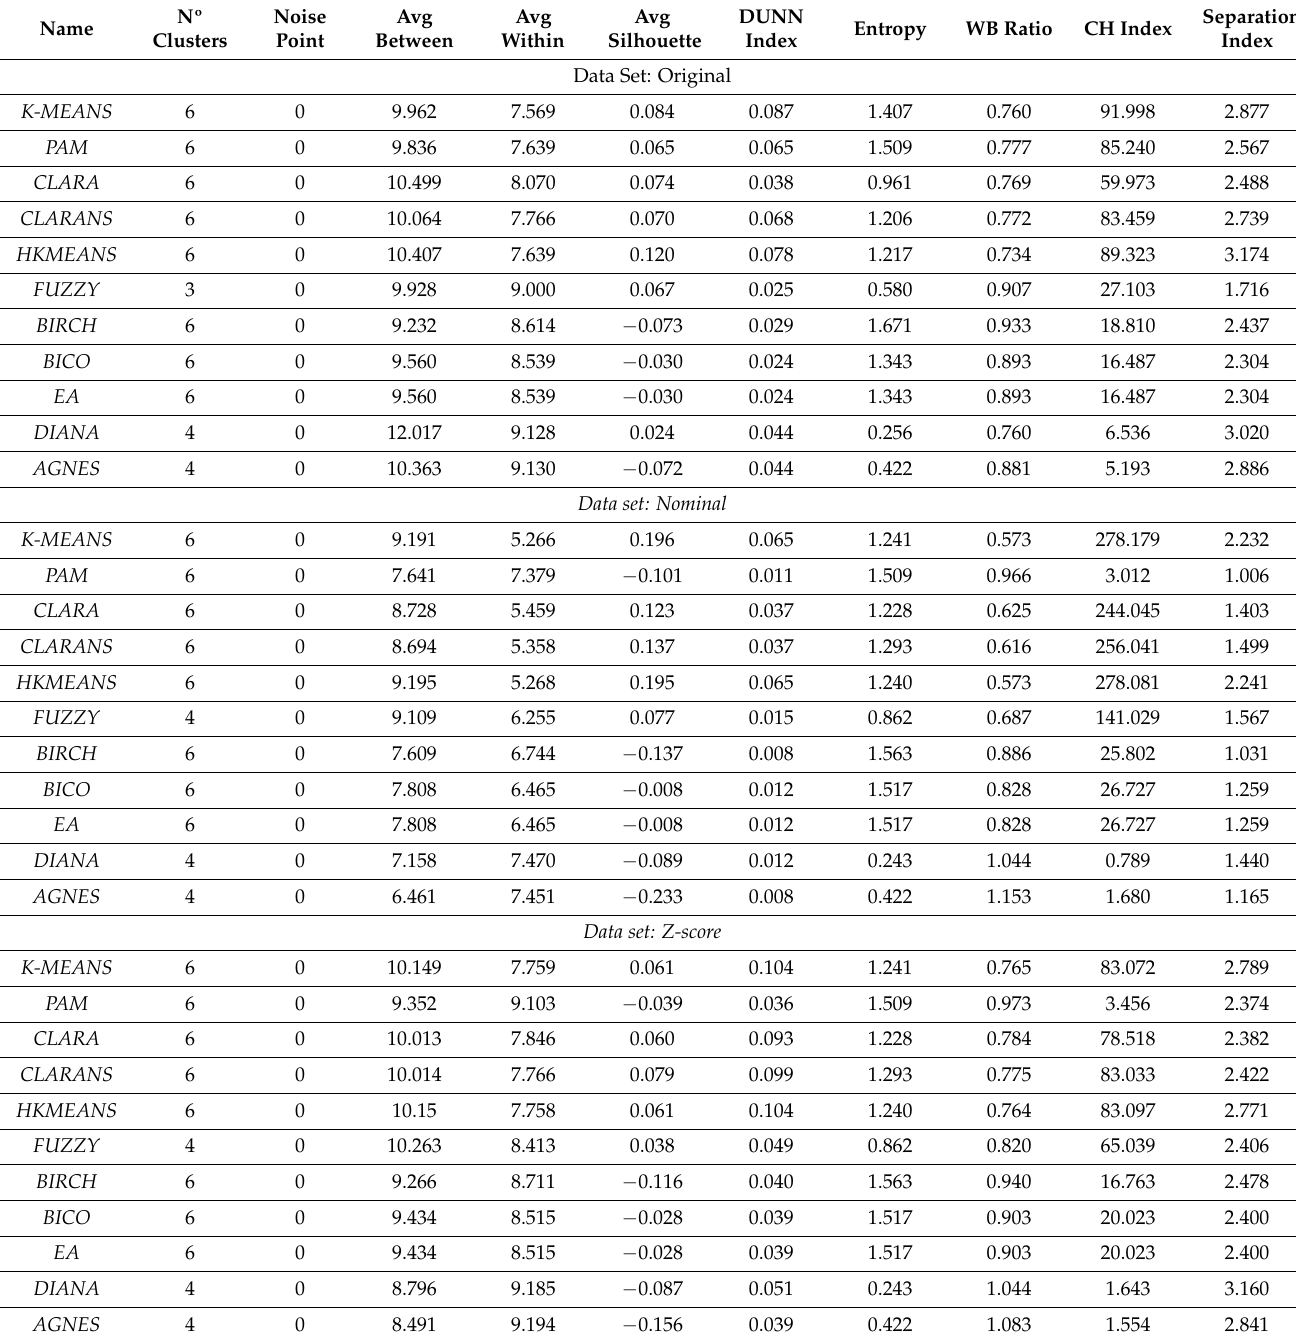
Table 2. External and internal validation of